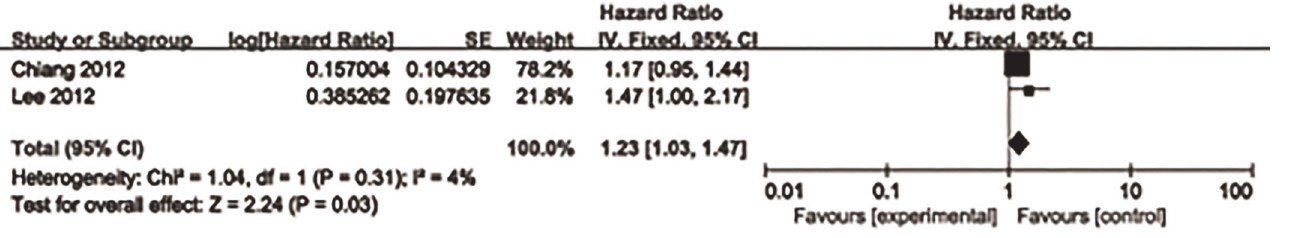
Fig 2. Forest plot of the incidence of lung